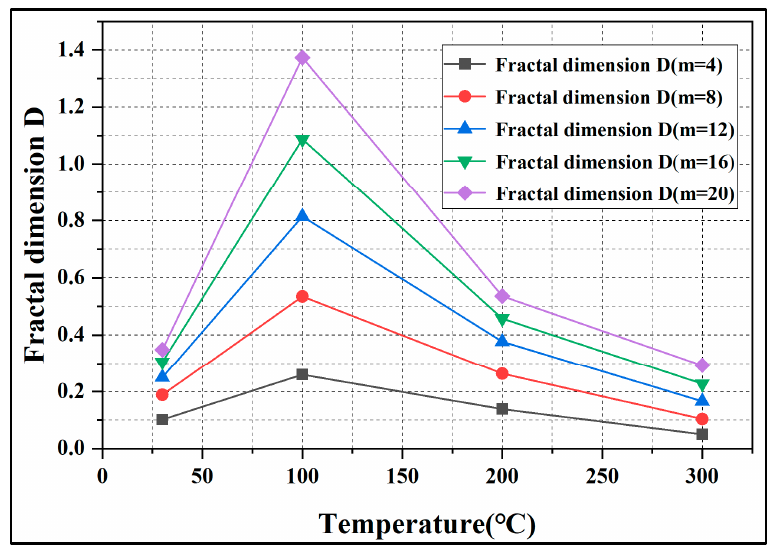
Figure 12. Variation of fractal dimension of AE counts with different m values.